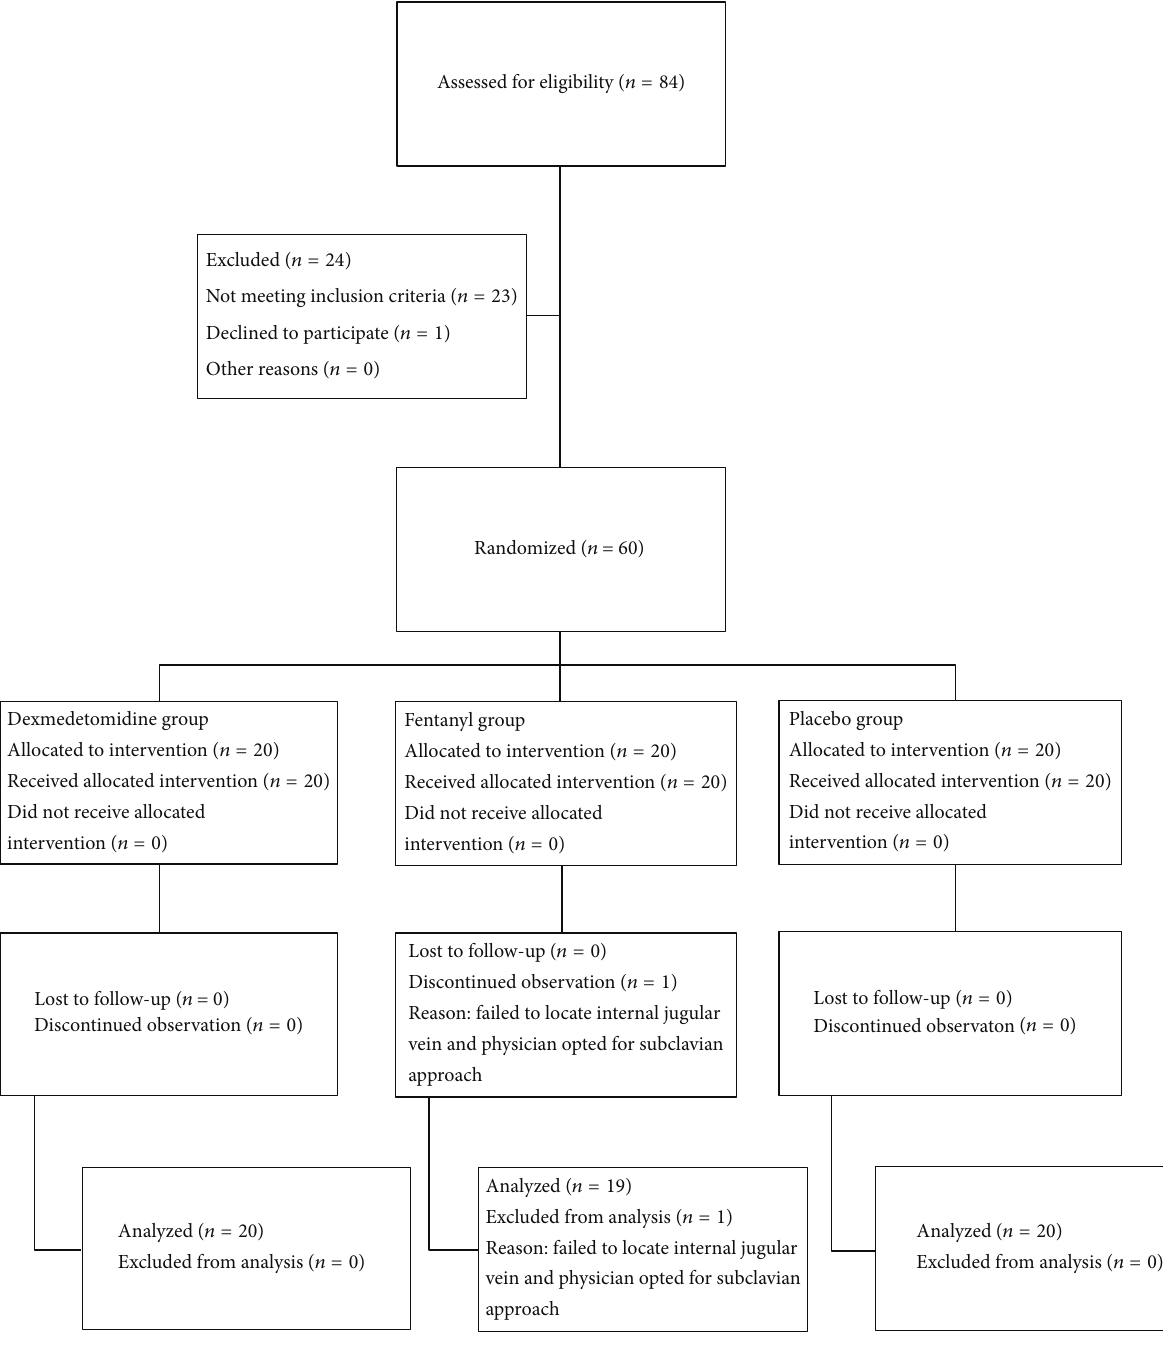
Figure 1: CONSORT patient flow